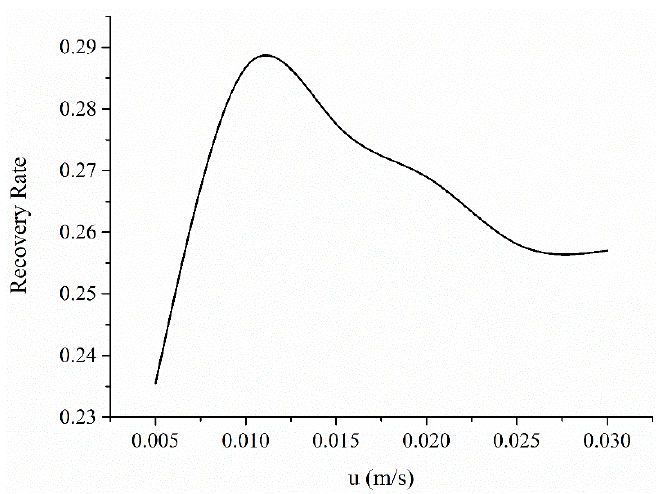
Figure 7. Variation of the final oil recovery rate with the injection velocity.